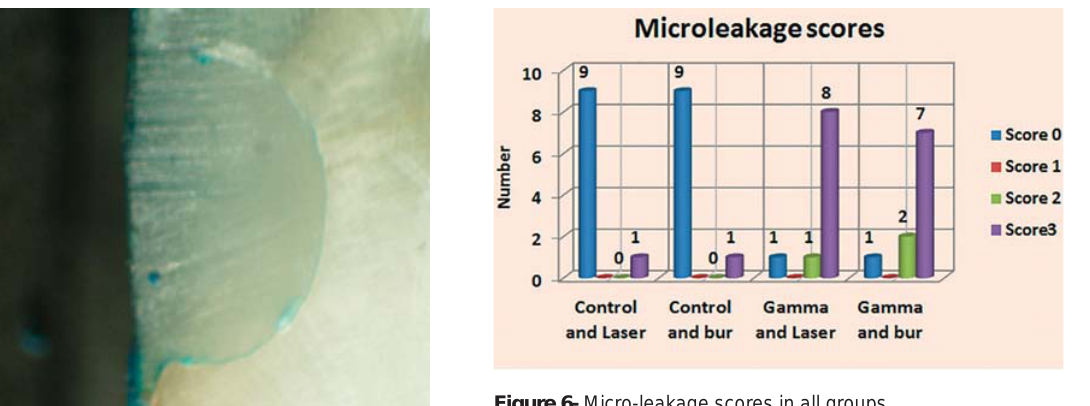
Figure 6- Micro-leakage scores in all groups